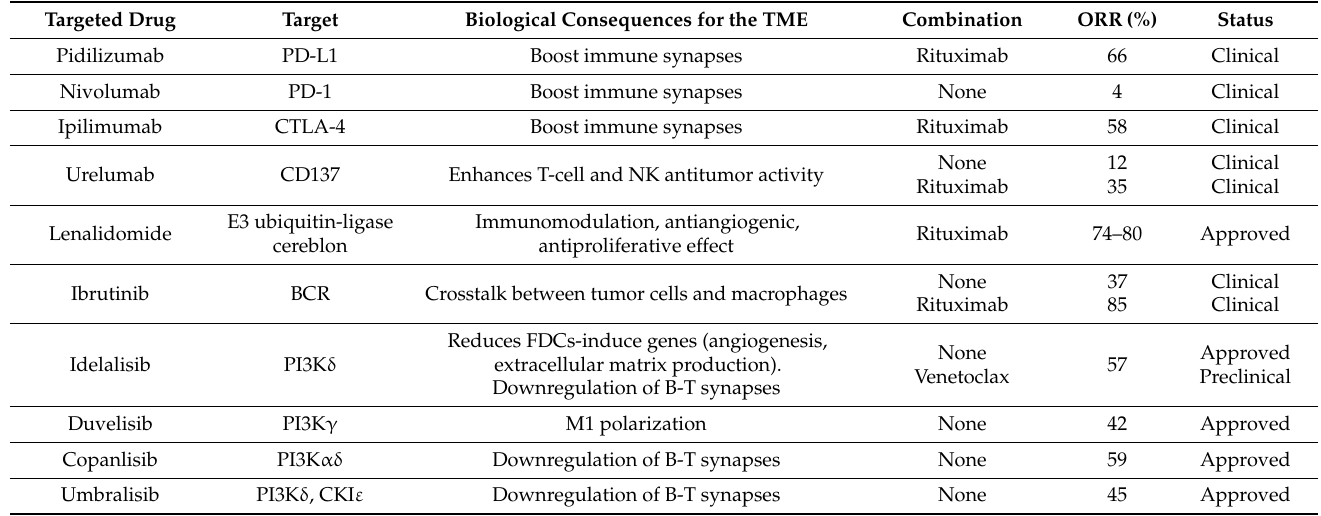
Table 2. Current therapies against FL and